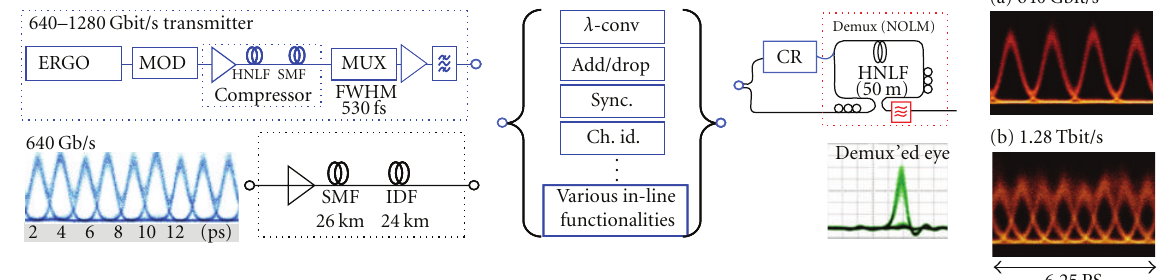
Figure 1: Schematic of the DTU OTDM test bed for generating 640–1280 Gbit/s data. Insets: (a) 640 Gbit/s eye diagram, (b) 1.28 Tbit/s eye diagram.